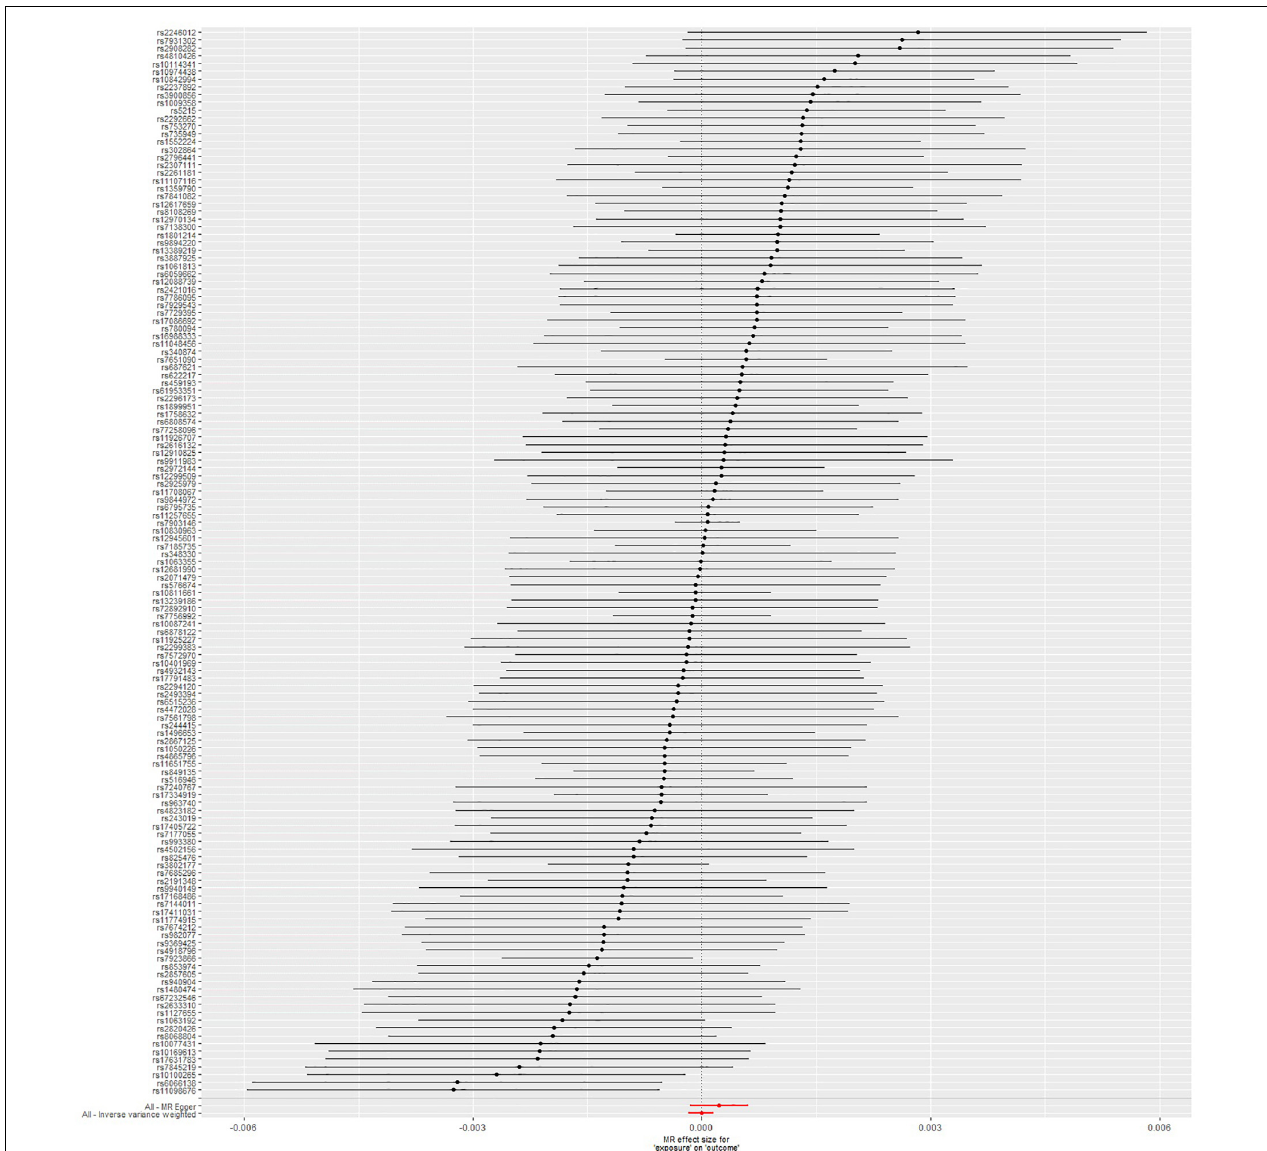
FIGURE 2 | Forest plot: the associations between T2DM-related SNPs and sepsis risk. T2DM, type 2 diabetes mellitus; SNPs, single-nucleotide polymorphisms; OR, odds ratio; CIs, confidence